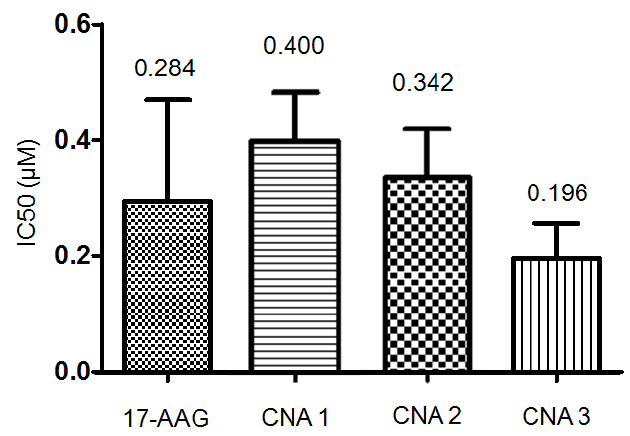
Figure 4. IC values of CNAs entrapping 17-AAG in A549 cell 50